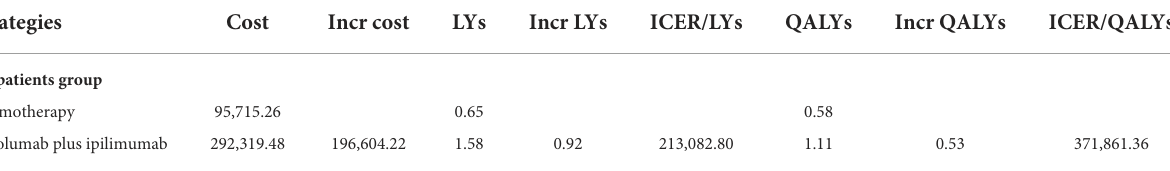
TABLE 2 Base-case analysis results.